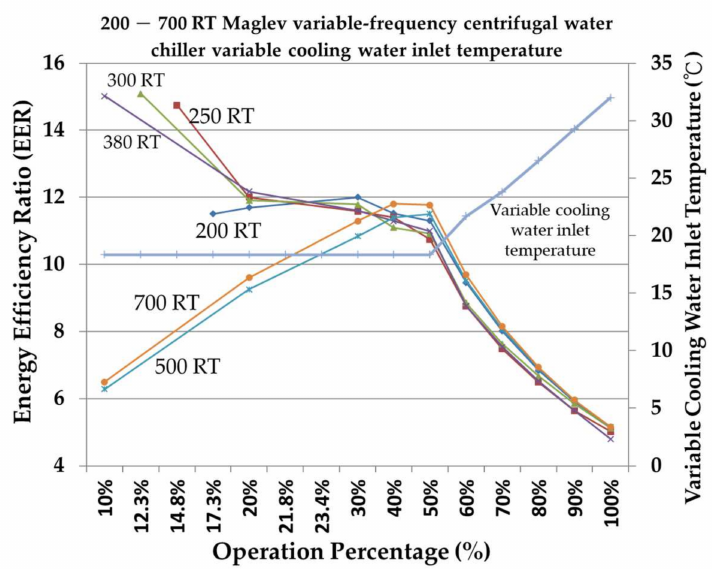
Figure 18. Variable-cooling water inlet temperature EER of the 200–700 RT Maglev variable-frequency water